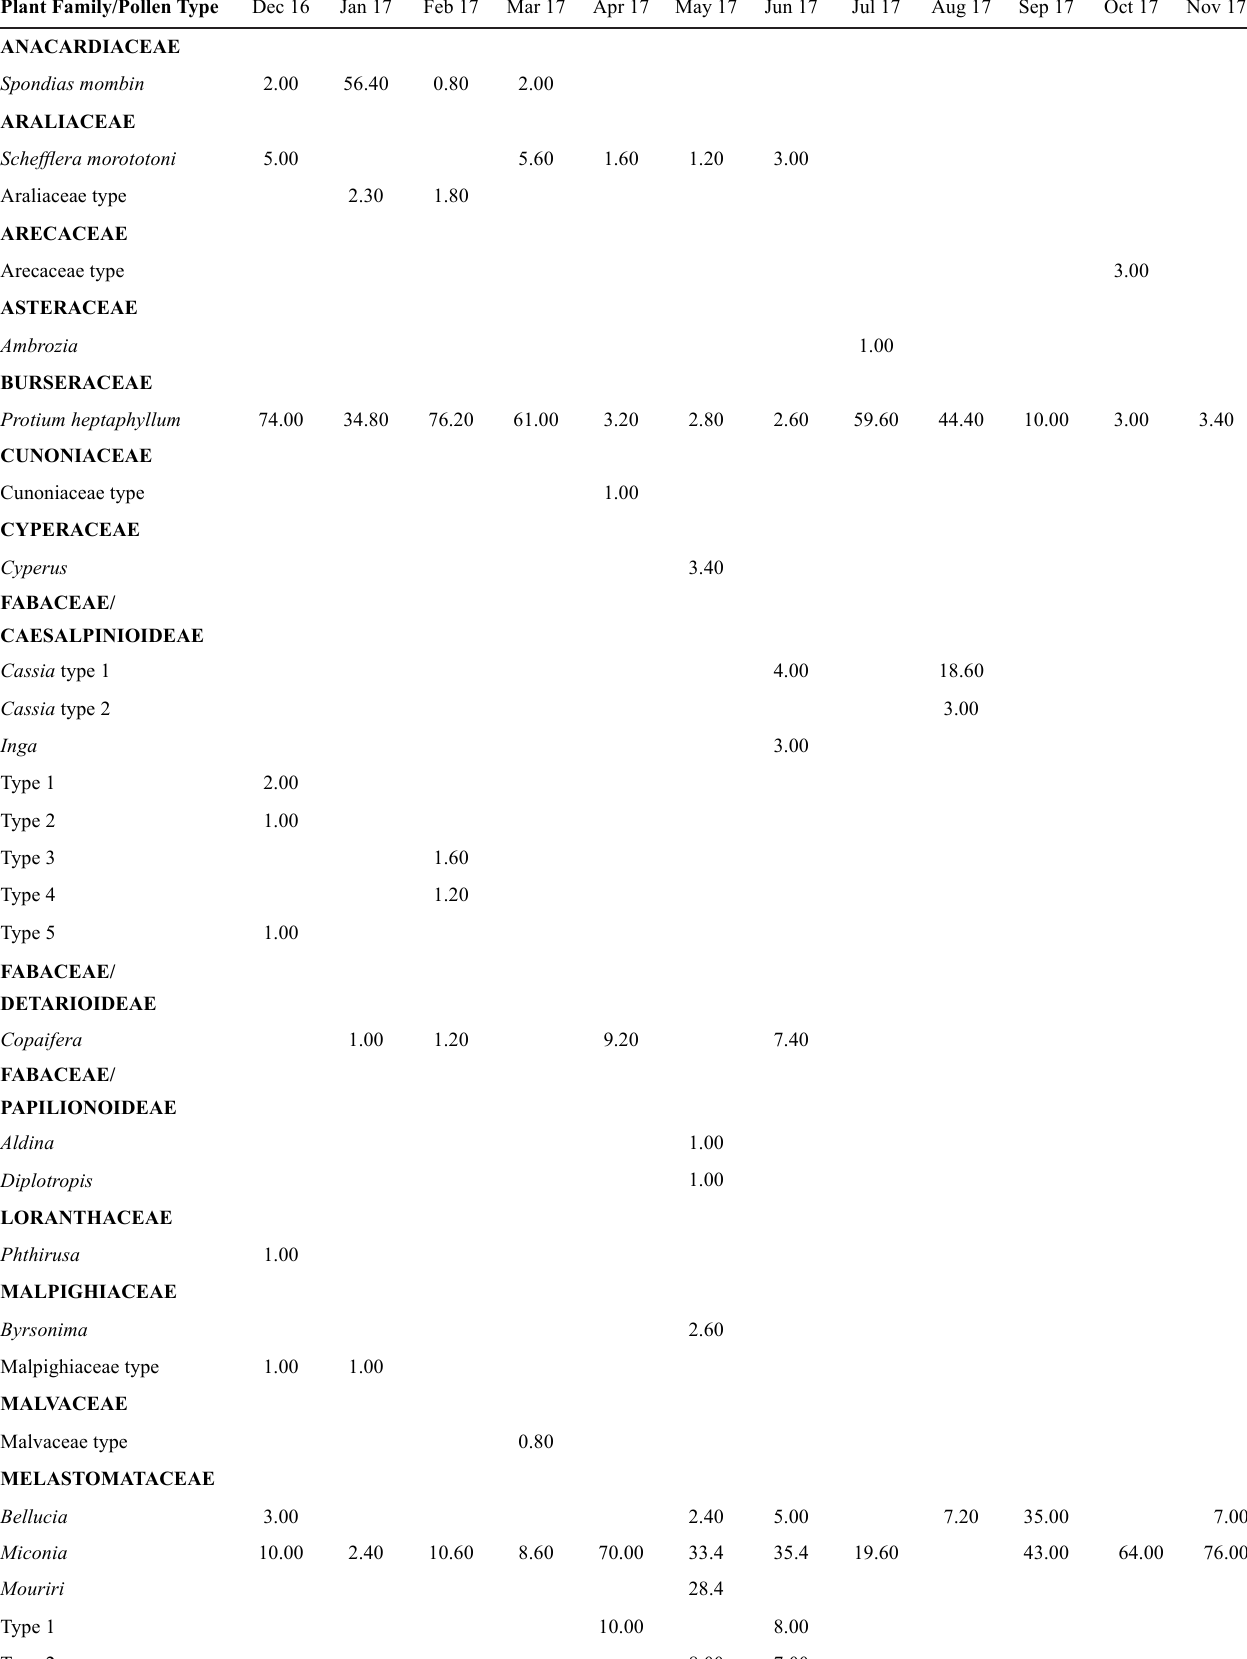
Table 2 . Frequency of pollen types found in honey samples of Melipona interrupta (Apidae: Meliponini) collected from December 2016